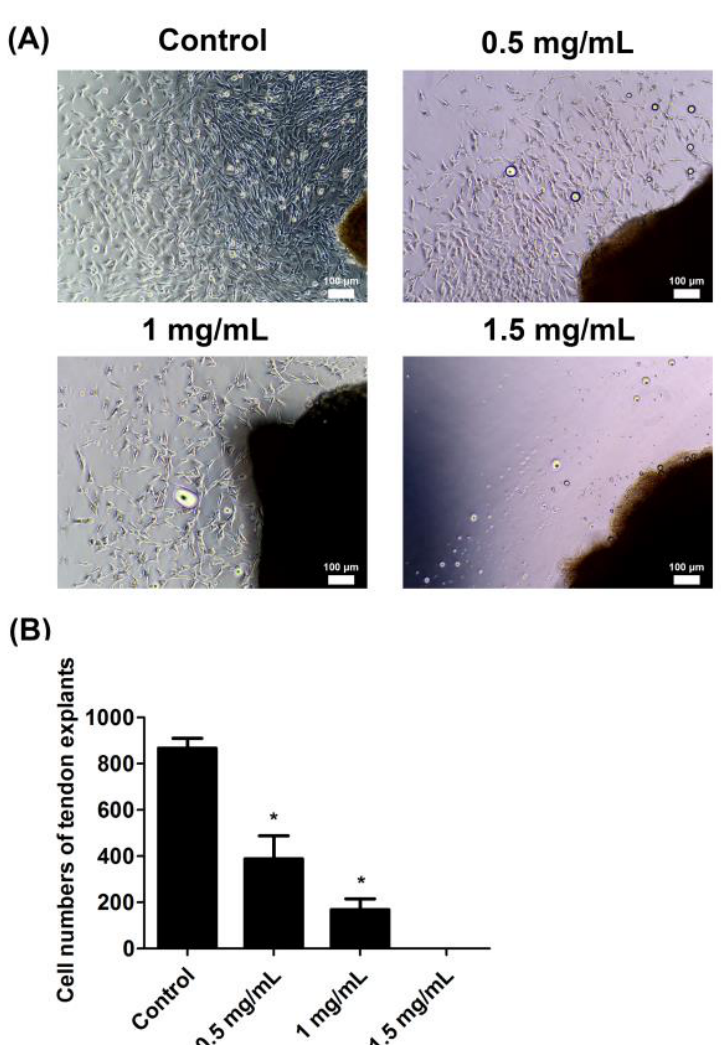
Figure 1. Lidocaine reduced tendon cell proliferation ex vivo. ( A ) Tendon explants were seeded in culture plates and were either left untreated or were treated with lidocaine (0.5, 1.0, or 1.5 mg/mL). ( B ) The cell numbers of the tendon explant in the control, 0.5, 1.0, or 1.5 mg/mL groups. Data are presented as the means ± standard errors of the mean of three independent experiments. * p < 0.05.